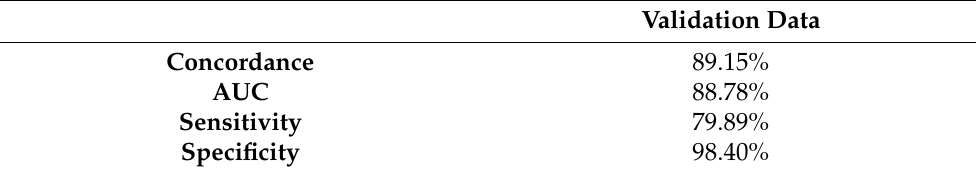
Table 8. Sensitivity Performance of